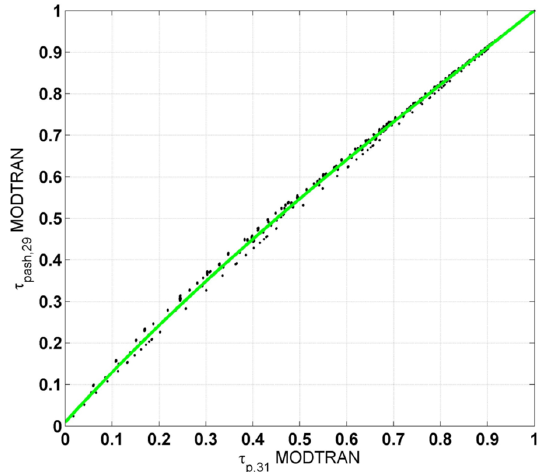
Fig. 5. Trend of TERRA m 31 (cid:14) m 32 and m 31 slopes versus the ef- fective radius R e . Fig. 6. Plume transmittance of TERRA band 29 vs plume trans- mittance of TERRA band 31 considering only ash in the volcanic plume. Green line is a cubic polynomial fit. Table 2. Cubic polynomial relationship coefficients (see Eq. 15) computed for the MODIS-Terra and MODIS-Aqua